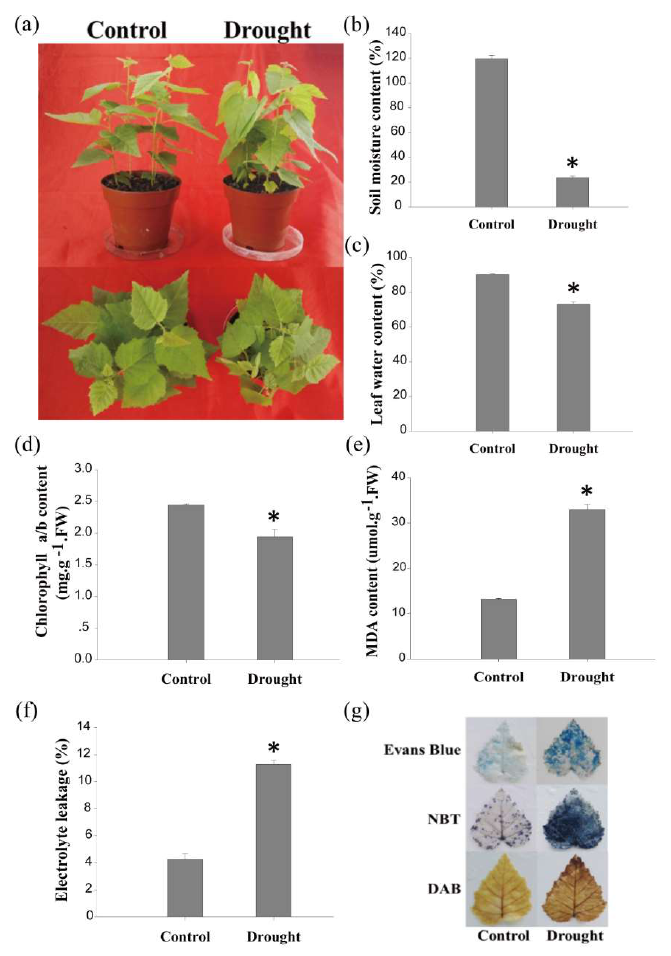
Figure 1. Drought treatment of birch plants. ( a ) The growth phenotype of birch under drought or normal (control) growth conditions. Watering of birch plants grown in soil was stopped for 120 h, and the well-watered birch plants served as the controls; ( b ) measurements of soil moisture; ( c ) leaf water content study; ( d ) measurements of total chlorophyll; ( e ) MDA content analysis; ( f ) electrolyte